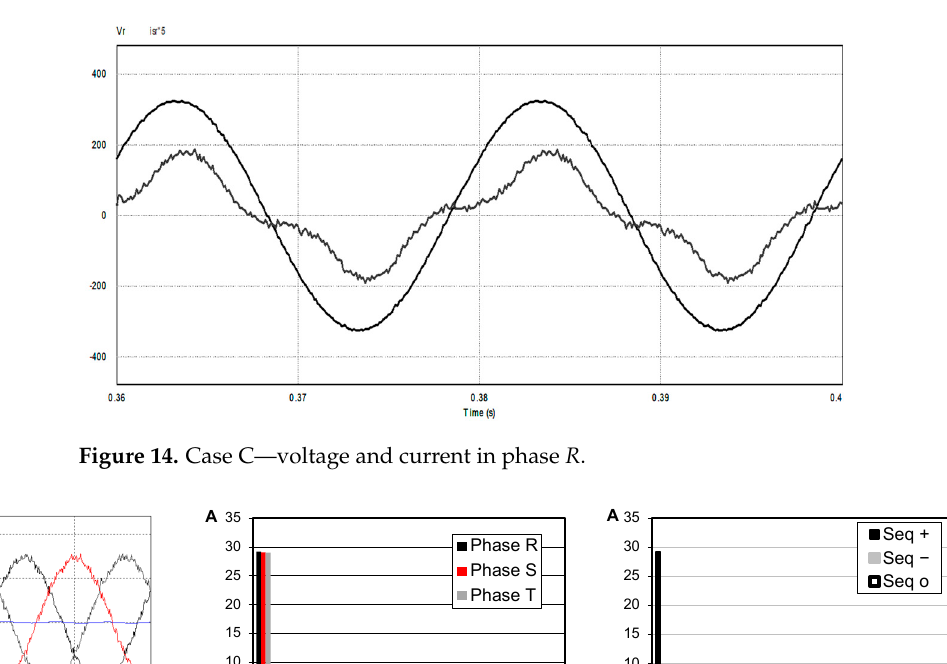
Figure 15. Case D - ( a ) supply currents (phases R , S , T , and neutral); ( b ) harmonic spectrum of phase components; ( c ) harmonic spectrum of the symmetric components.